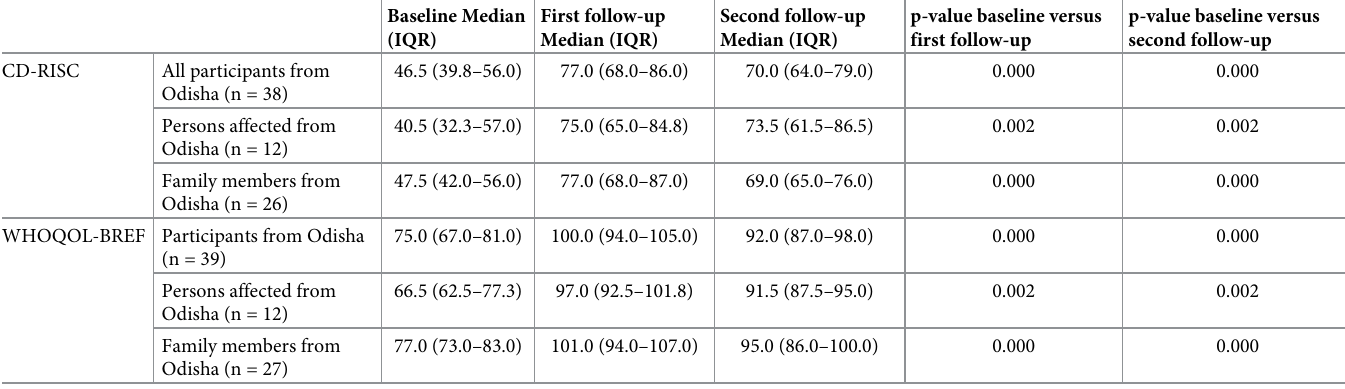
Table 3. Difference in baseline and first and second follow-up in resilience scores (CD-RISC) and quality of life scores (WHOQOL-BREF) in Odisha